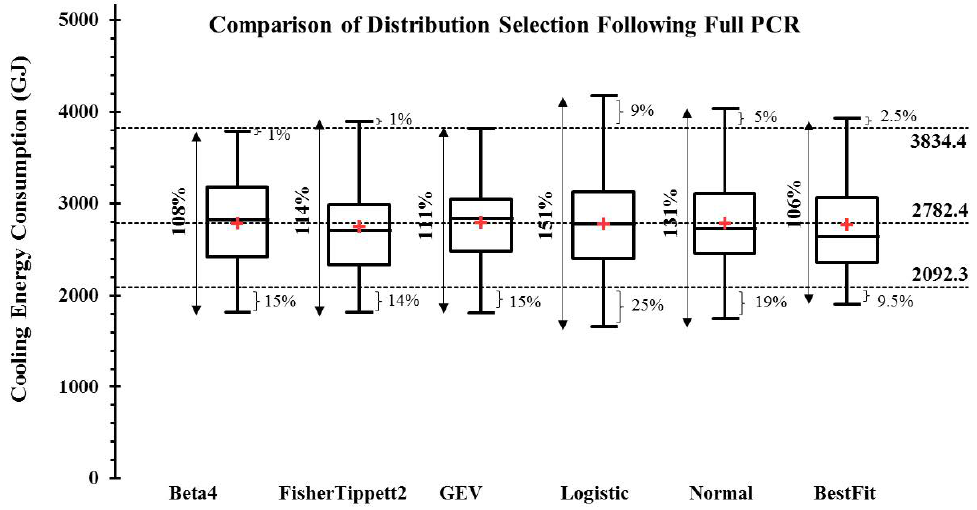
Figure 13. Cooling energy use probability density functions when following a Full Principal Component Regression model and comparing selection of various input principal component distribution series used in the uncertainty propagation method.